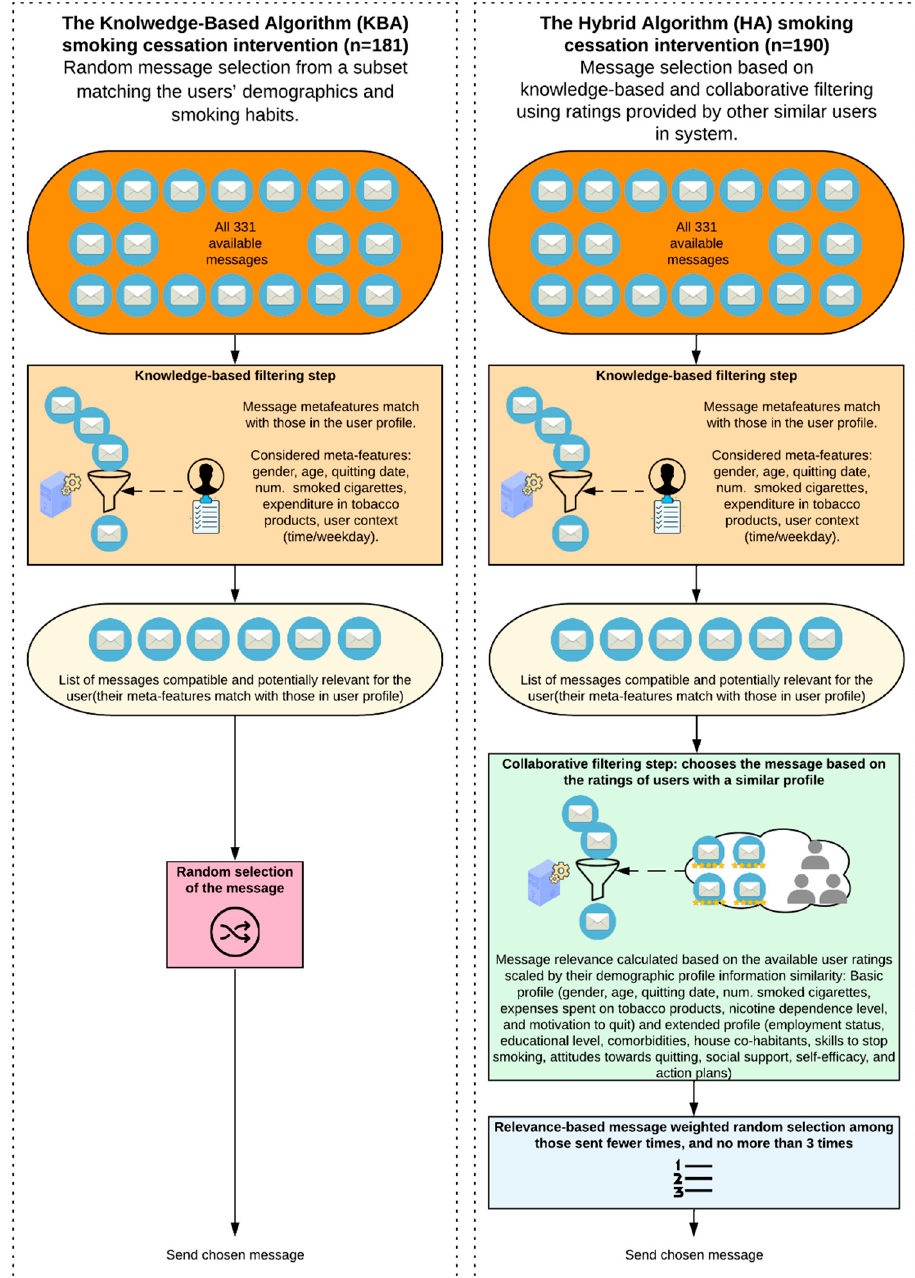
Figure 2. Message selection summary for the two HRSs used in the study.